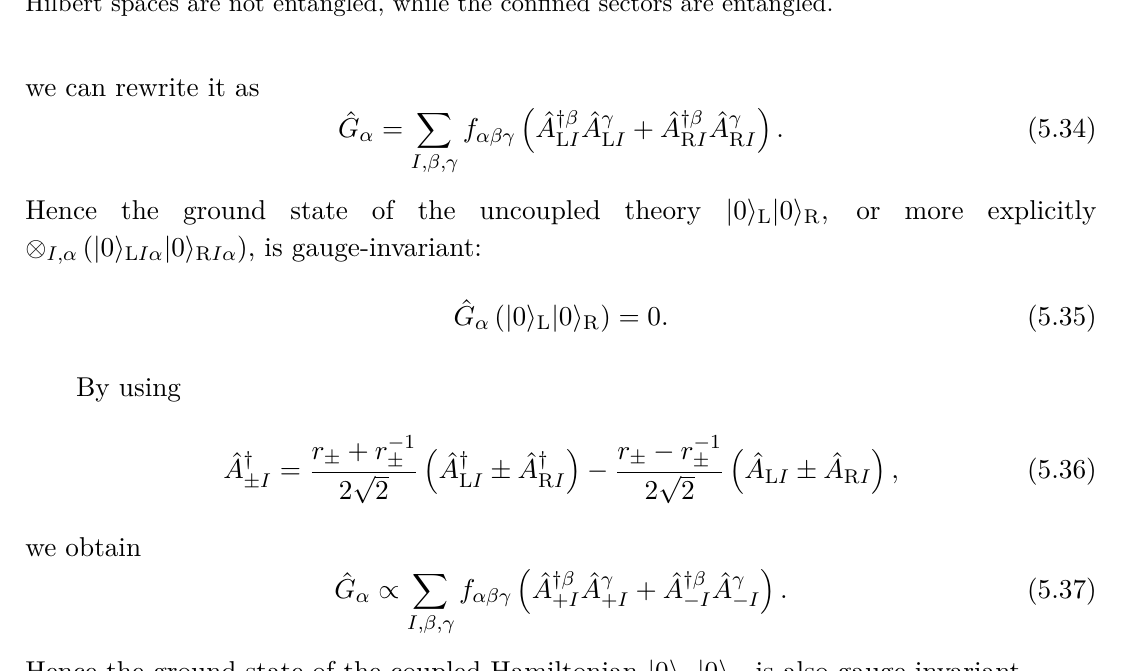
Figure 11 . Partial deconfinement phase in the matrix model, at small but finite deformation parameter C + (cid:28) 1 . When the energy is not large enough such that all degrees of freedom are deconfined, only a part of degrees of freedom deconfine. The deconfined sectors in the left and right Hilbert spaces are not entangled, while the confined sectors are